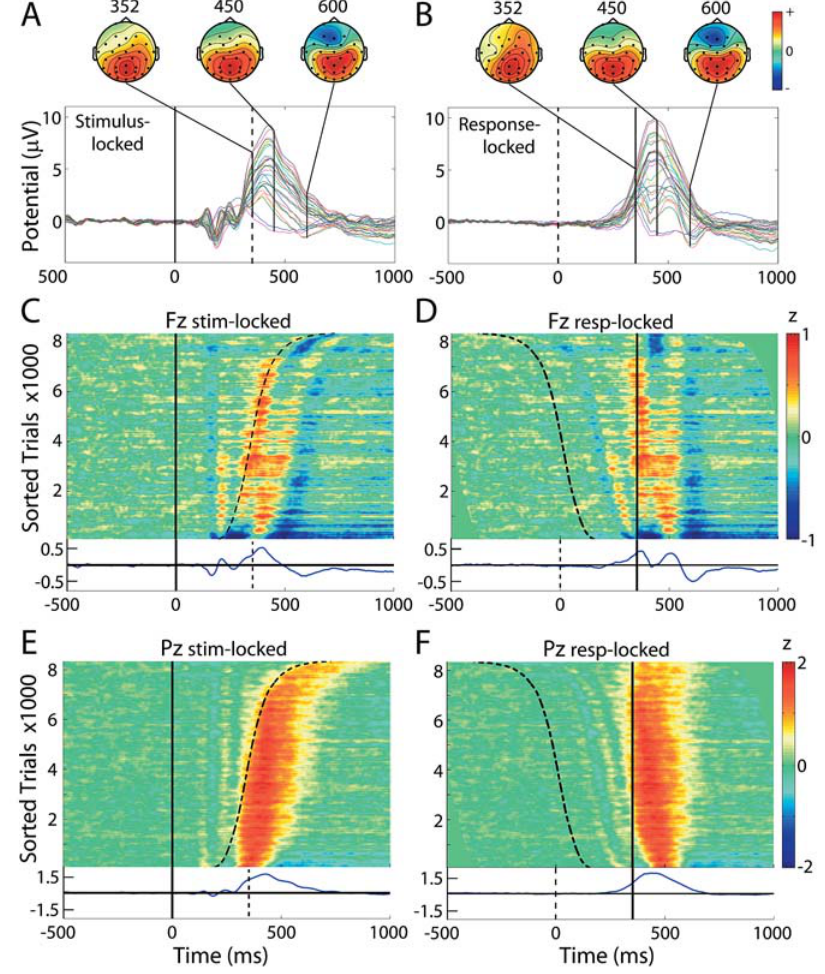
Figure 2. Grand Mean and RT-Sorted Single-Trial Responses at Sites Fz and Pz (Left) Stimulus-locked grand mean and (right) response-locked grand mean re- sponses to target stimuli. (A and B) Grand mean responses at all 29 scalp channels (colored traces), plus scalp maps at indicated latencies. (C–F) Grand moving mean single-trial responses from all 15 subjects, at fronto- central site Fz (C and D) and at central parietal site Pz (E and F), plotted in ERP- image format and sorted by subject RT (curving dashed trace in left column; vertical solid line in right column, plotted at the mean subject-median response time of 352 ms). ERP-image units: z = microvolts divided by root- mean-square microvolts in the ( (cid:1) 1000 ms to 0 ms) channel baseline EEG of the same subject after removal of eye and muscle artifact components from the data. Vertical smoothing window: 300 trials. Grand mean normalized responses are shown below each image. DOI: